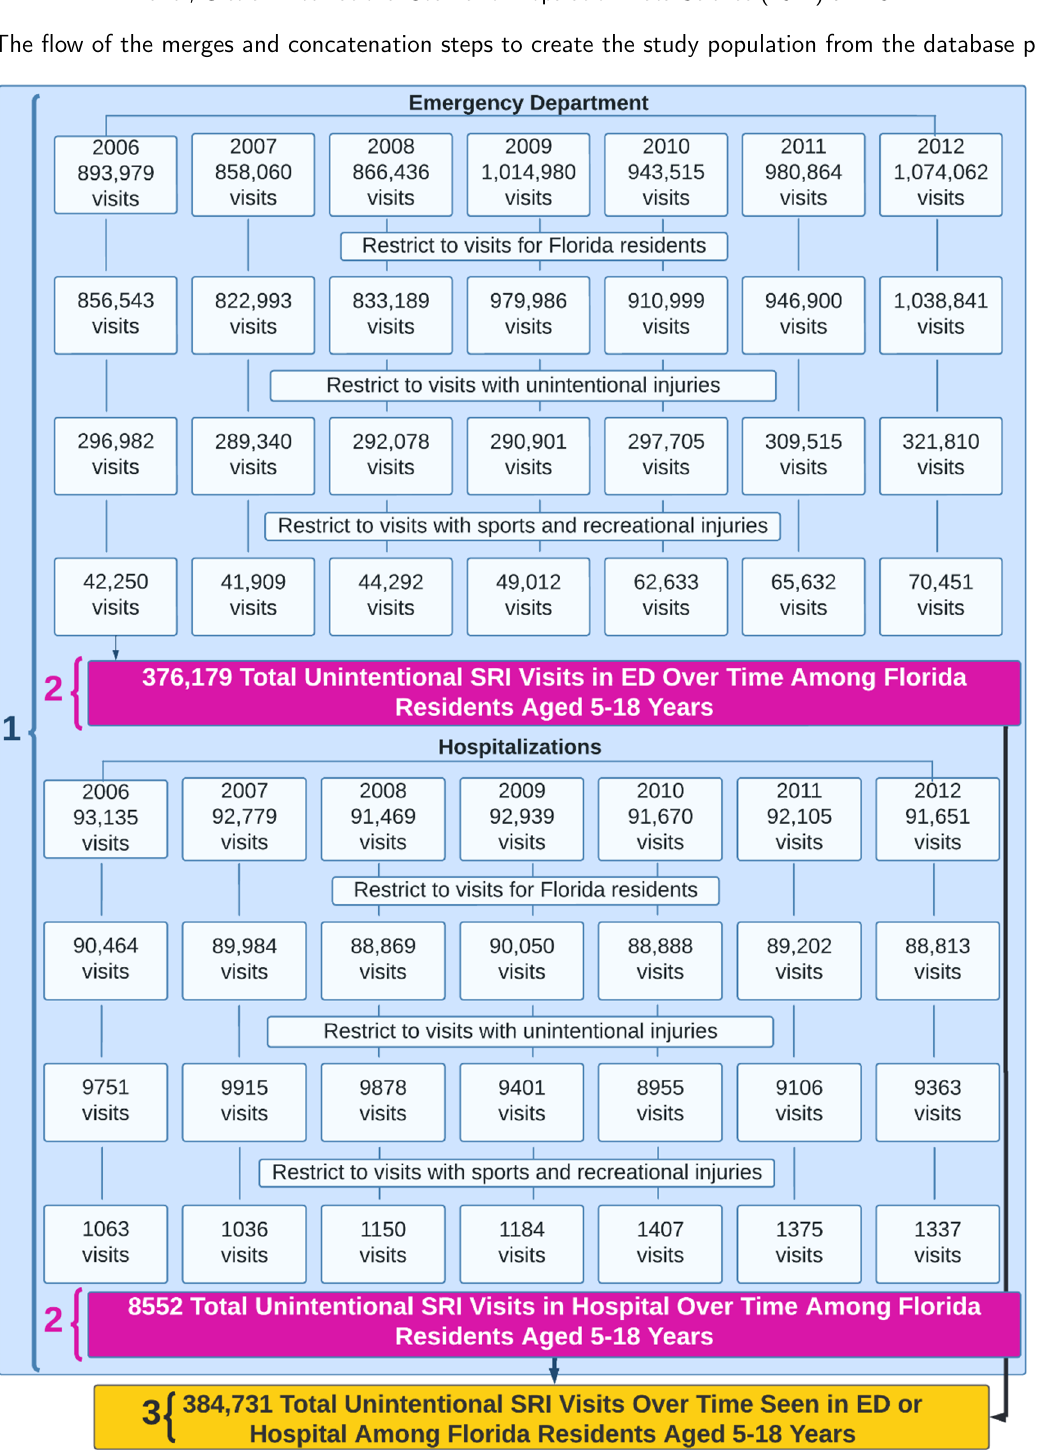
Figure 5: The flow of the merges and concatenation steps to create the study population from the database